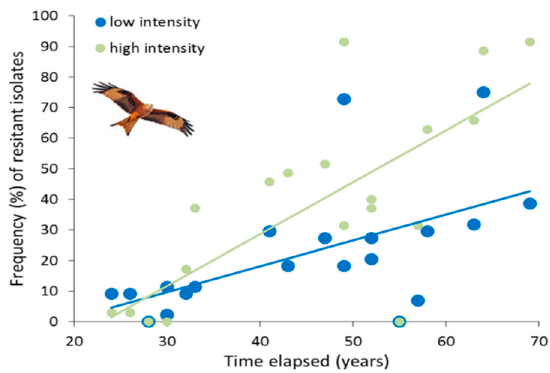
Figure 3. Relationships between the frequency (%) of resistant E. coli isolates to each antibiotic in red kites and the time (in year) elapsed since the beginning of the commercial application of each antibiotic. Least squares regression lines of the correlations are shown for graphical representation of trends corresponding to the low- and high-intensity farming areas in Central Spain. Two pairs of overlapping data points with resistance frequency = 0 in both the low- and high-intensity areas correspond to colistin and imipenem.